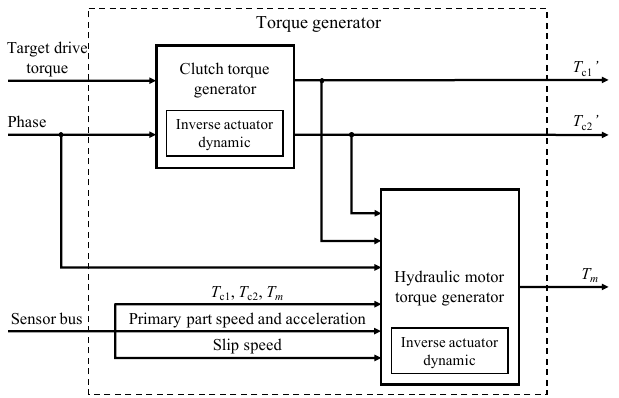
Figure 5. Torque